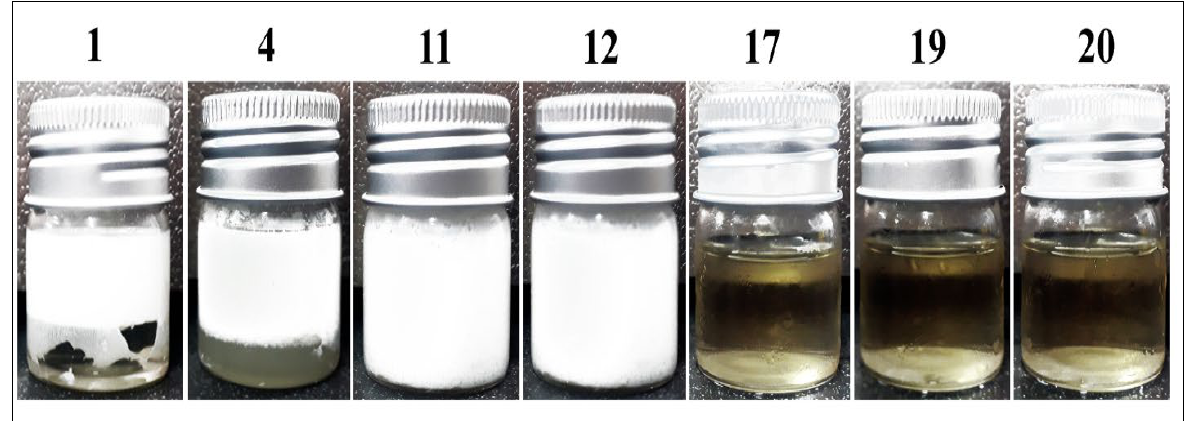
Figure 2. P hotographed MEs, wherein formulation numbers 17, 19, and 20 are